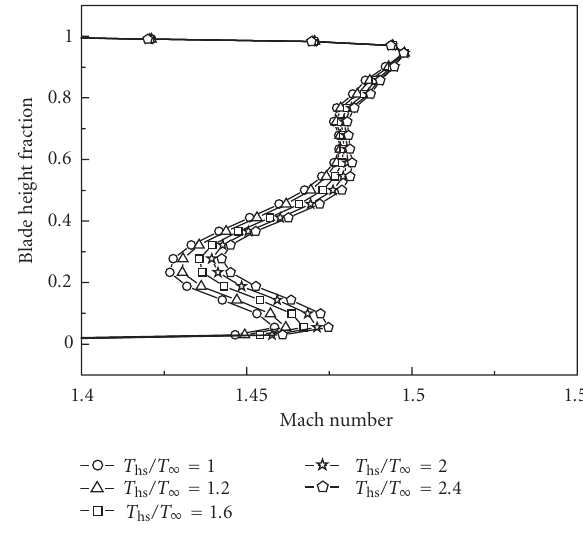
Figure 13: Time- and pitch-averaged Mach number distributions at the outlet of the HPT rotor.